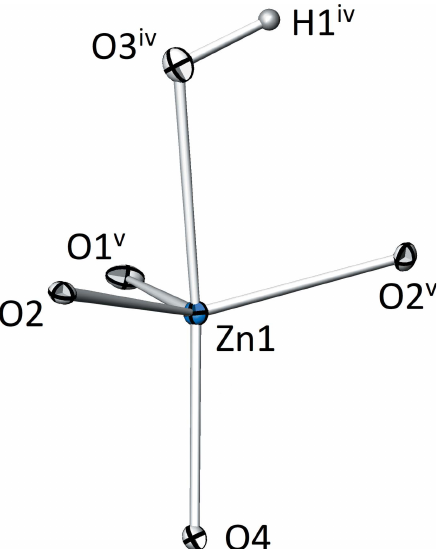
Figure 1 The distorted trigonal–bipyramidal [ZnO 4 OH] polyhedron in the crystal structure of Zn 2 (HTeO 3 )(AsO 4 ). Displacement ellipsoids are drawn at the 90% probability level. Symmetry codes refer to Table